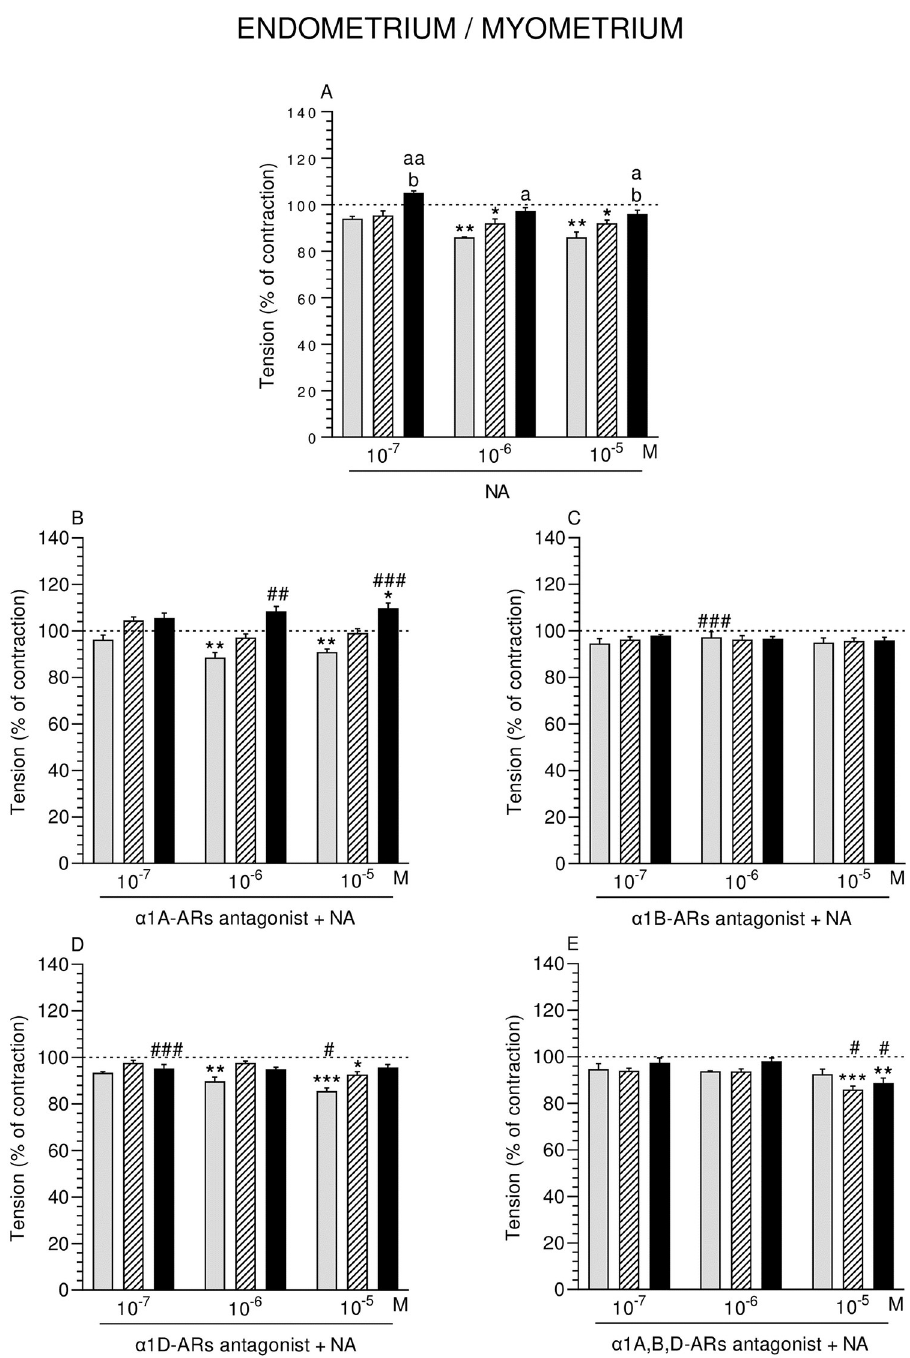
Fig 3. Effect of noradrenaline (NA) alone (A) and NA with α 1A- (B), α 1B- (C), α 1D- (D) and α 1A,B,D (E)– adrenoreceptors (ARs) antagonists (a dose of 10 − 4 M) on the tension of con-tractions in pig endometrium/ myometrium strips obtained from the CON (grey bars), SAL (hatched bars), and E . coli (black bars) groups. Data from five experiments (gilts, in each group). Effects of particular doses of NA and antagonists are expressed as percentage (mean ± SEM) in relation to the basal (pre-treatment period) contractile tension, established as 100% (horizontal lines). � P < 0.05, �� P < 0.01, ��� P < 0.001—indicate differences from baseline in each group; a P < 0.05, aa P < 0.01- indicate differences between CON and E . coli groups for the same treatment; b P < 0.05—indicates differences between SAL and E . coli groups for the same treatment; # P < 0.05, ## P < 0.01, ### P < 0.001 compared between particular antagonist with NA effect versus NA effect alone for the same group/NA